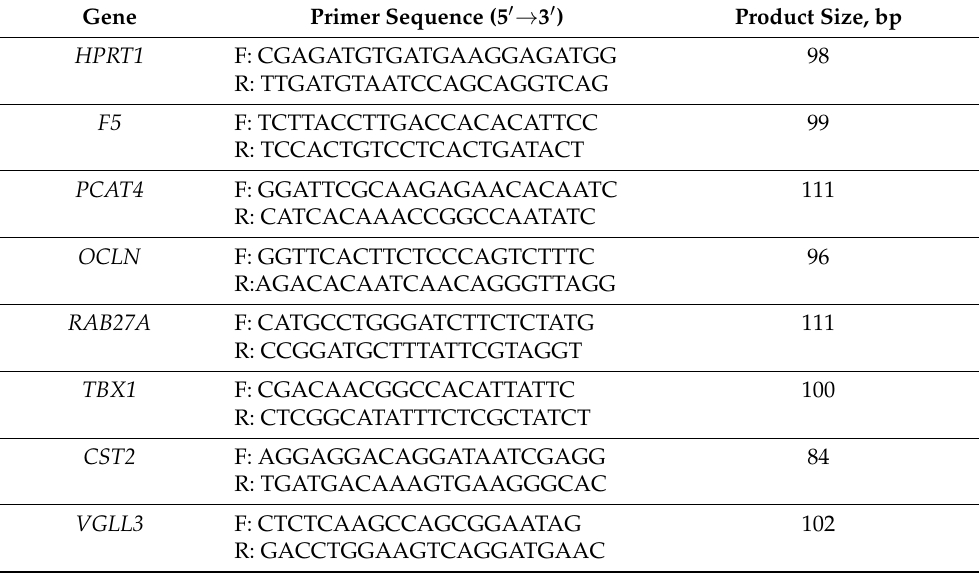
Table 7. Primer sequences for detection of marker gene expression by